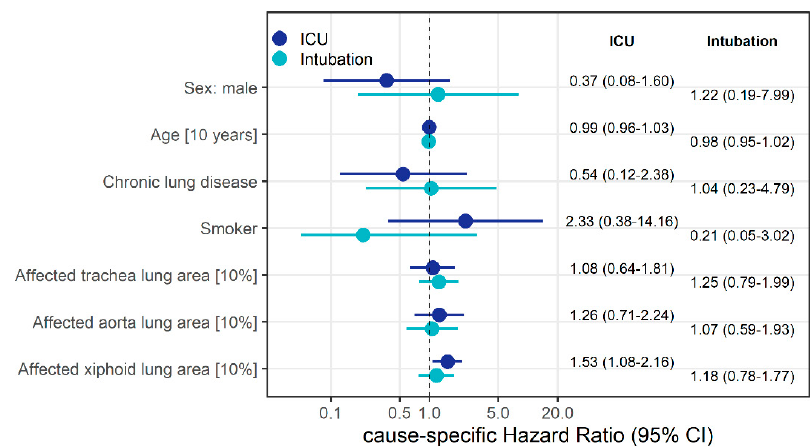
Figure A1. Cause-specific hazard ratio estimates along with 95% confidence intervals (CI) derived from competing risks Cox regression models to identify factors influencing the instantaneous risk of intubation. Events of interest were ICU admission and intubation, respectively; discharge was treated as a competing risk. All displayed variables were included in the model.